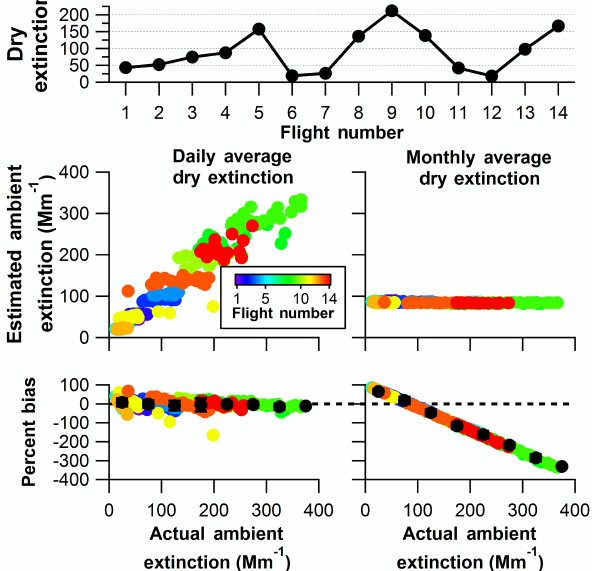
Figure 16. Average RH for each flight (top) along with estimated ambient extinction and percent bias if the flight-average (left) and campaign-average (right) RH are